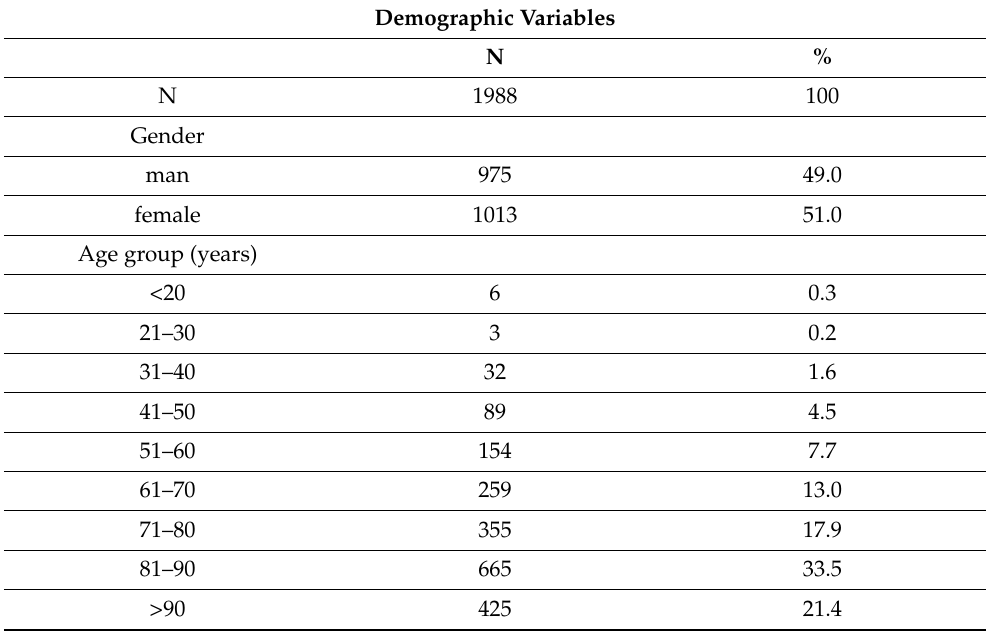
Figure 1. Flowchart for assessment of changes in medication problems between the first to the last home visit. Table 2. Participants’ demographic